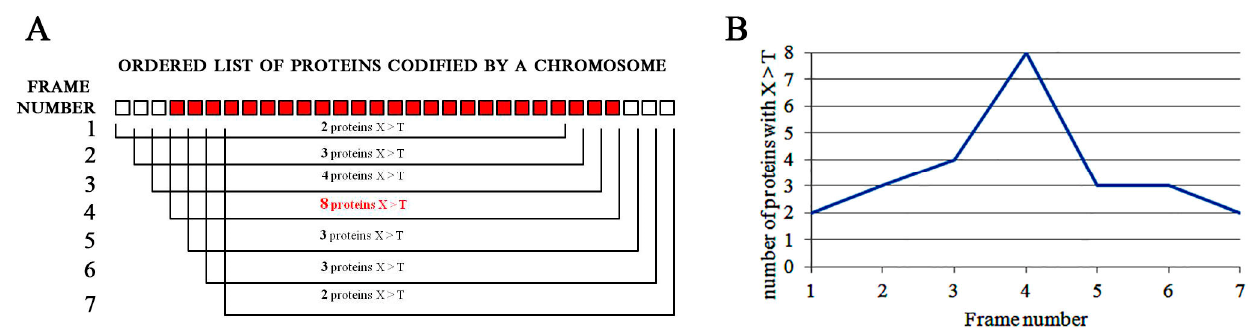
Figure 2. Outline of the walking procedure and surfing analysis. ( A ) The frameshift throughout the ordered list of proteins (represented by squares) is carried out, and in each frame, the number of proteins having the amount of a selected AA (X) higher than the threshold (T) is counted. The frame most enriched in X is shown in red. ( B ) These numbers are plotted on graph, obtaining a peak that highlights the region of the chromosome codifying for proteins enriched in the chosen AA.